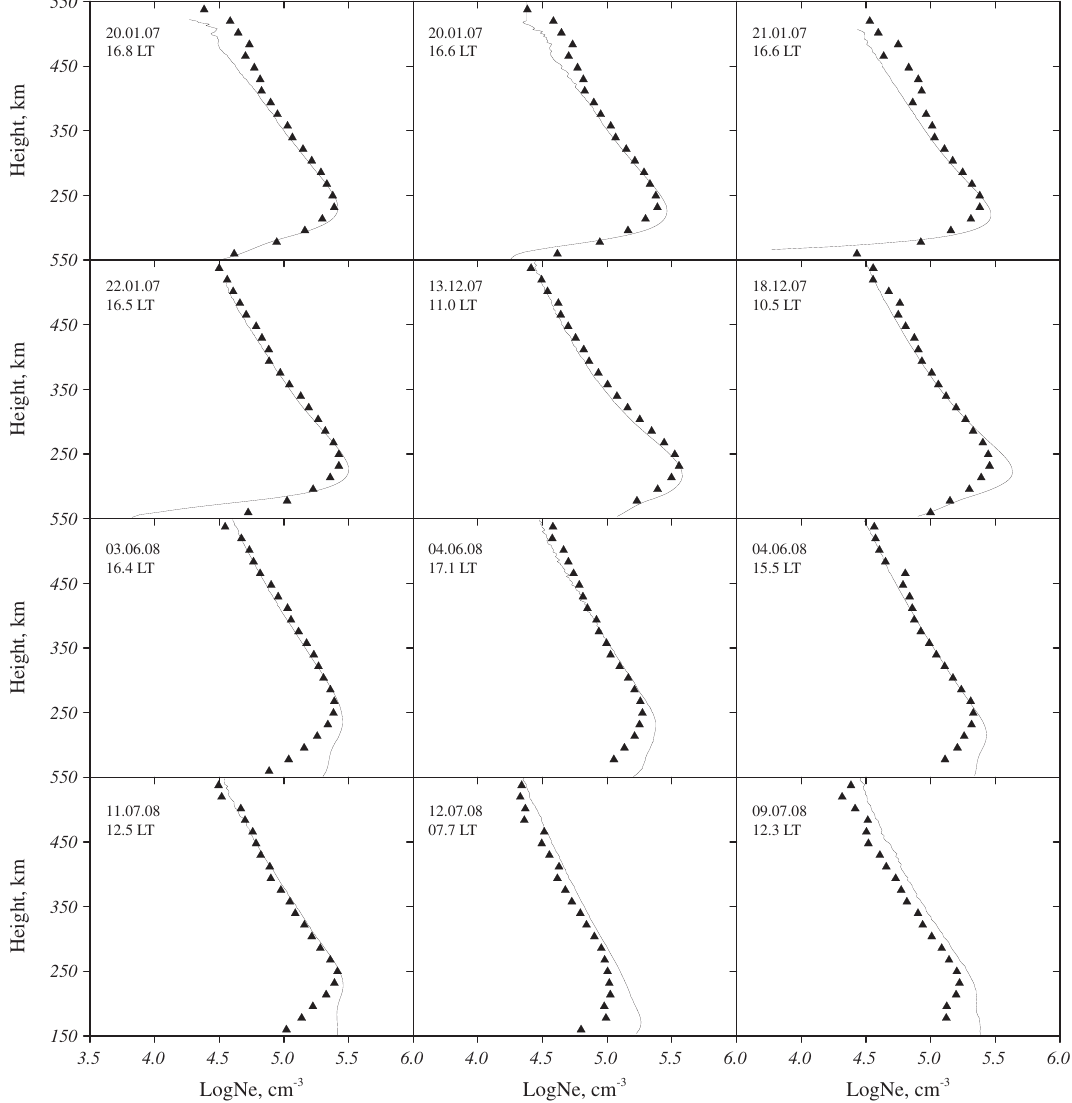
Fig. 5. Daytime Millstone Hill ISR EDP (triangles) in a comparison to COSMIC RO measurements (solid line) under solar minimum 2007–2008 conditions. Six of the best (top panels) and six of the worst (lower panels) coincidences are